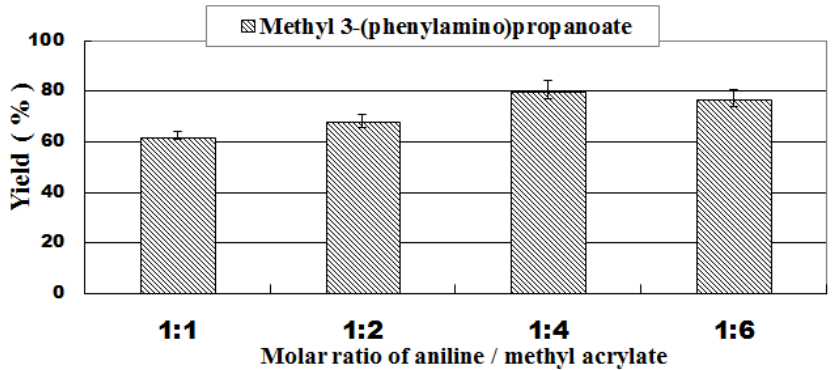
Figure 4. The effect of substrate ratio on enzymatic synthesis of β-amino acid esters in continuous-flow microreactors.